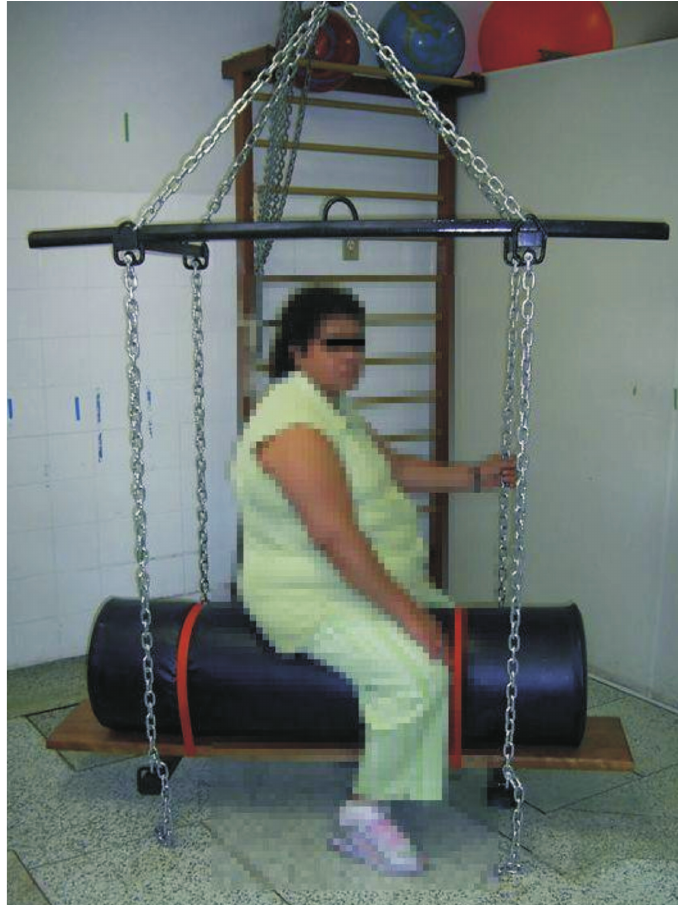
Figura 2 - Paciente sentada no balanço, com pés apoiados, tronco alinhado, 70° de flexão